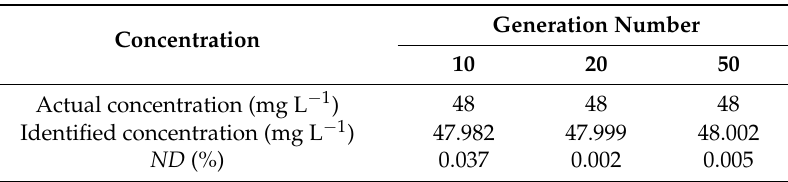
Table 4. Effect of variation in the generation number.